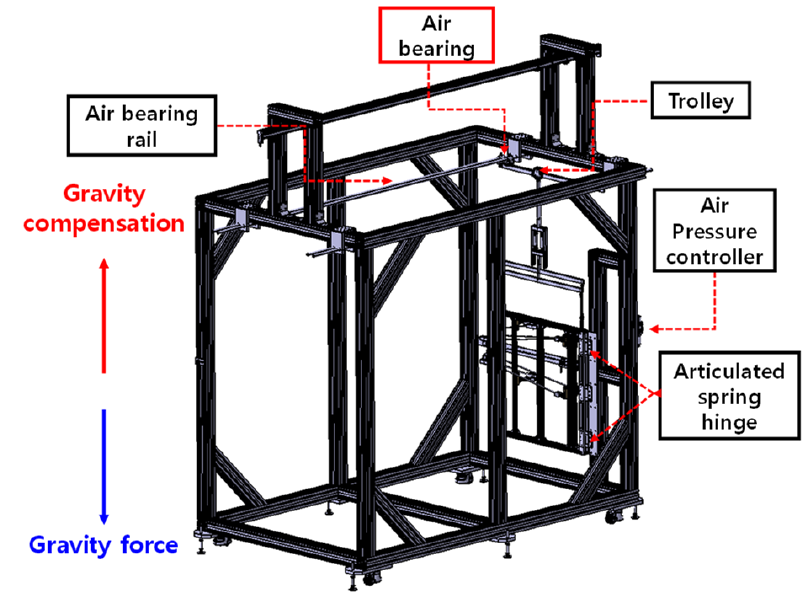
Figure 7. Test configuration of panels with truss-link mechanism [27].